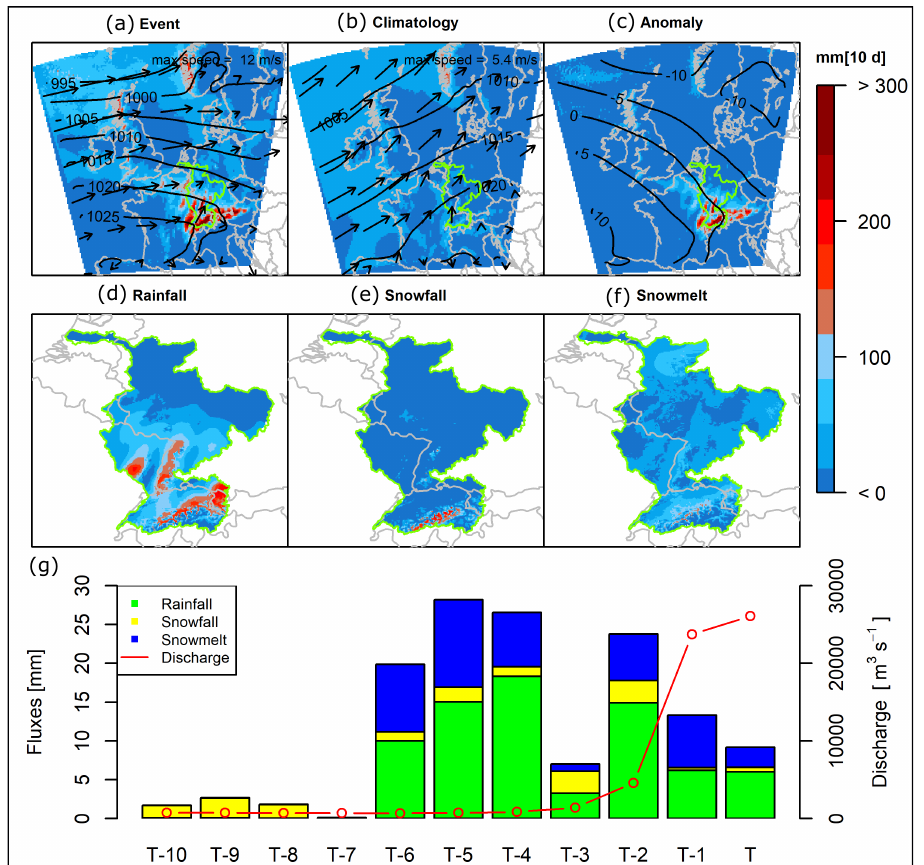
Figure 9. Meteorological circulation patterns leading up to the most extreme discharge event in the control simulation (date: 1953-12-27; member 10). Fields shown are composed of 10-day mean sea level pressure (SLP) and near surface wind and 10-day accumulated precipitation, rainfall, snowfall and snowmelt. Panel ( a ) shows the accumulated 10-day precipitation during the event together with the 10-day mean wind (arrows) and SLP (contours). Panel ( b ) shows the climatology of the event for the same 10-day episode in the ensemble. Panel ( c ) shows the anomaly of the event. Panels ( d – f ) show the rainfall, snowfall and snowmelt anomalies respectively. Panel ( g ) shows the sums of basin mean daily averaged fluxes of the hydrological budget terms during the event (colored bars) together with discharge (red